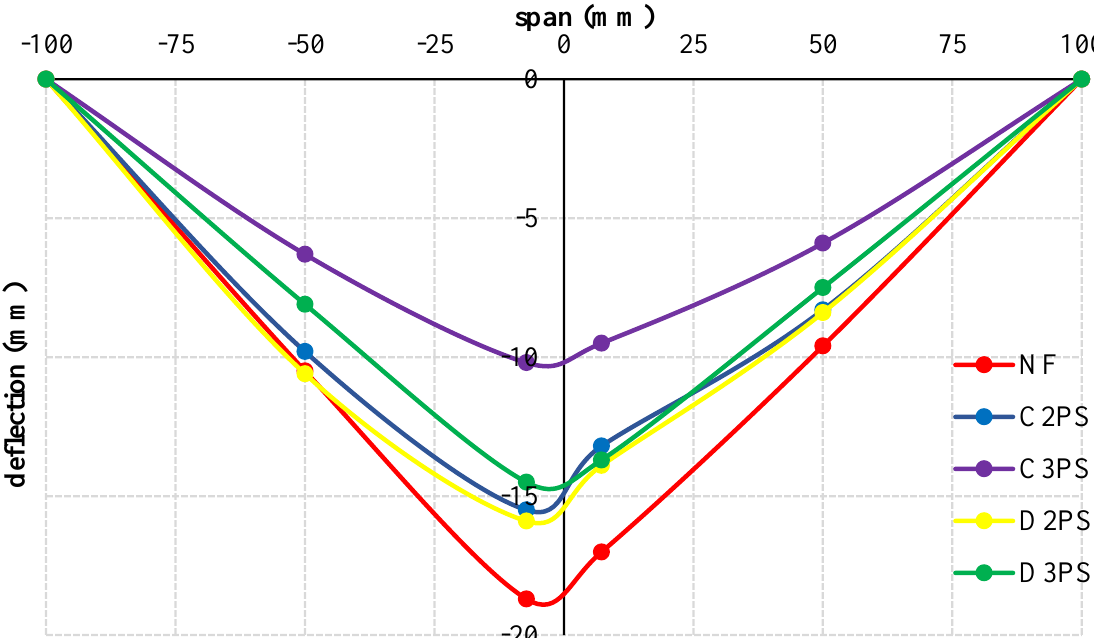
Figure 7. Deflection along specimens span at point of maximum load.